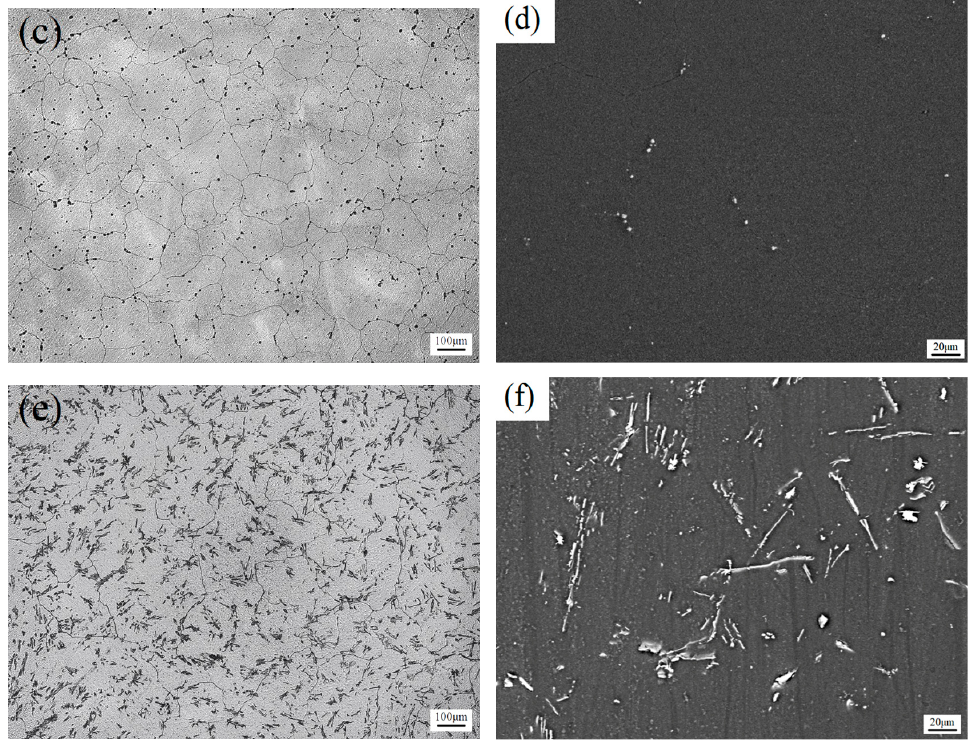
Figure 4. Optical microstructure and SEM images of as-homogenized samples: ( a , b ) Mg-6Sn; ( c , d ) Mg-6Sn-2Zn; and ( e , f ) Mg-6Sn-2Zn-1Ca.